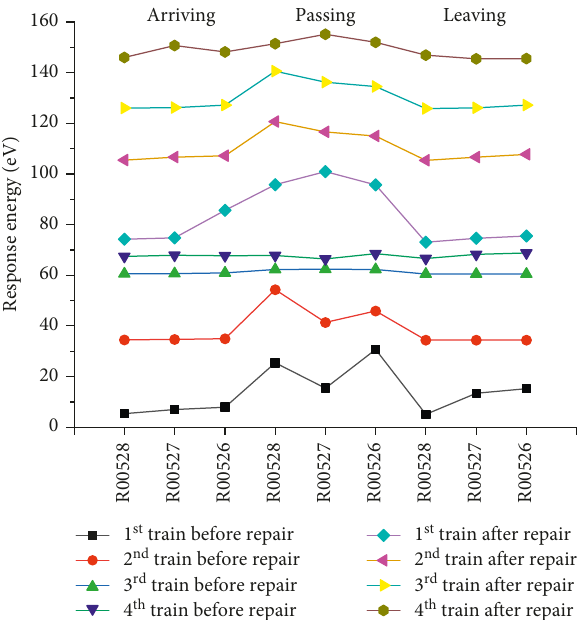
Figure 18: Response energy of the right track.